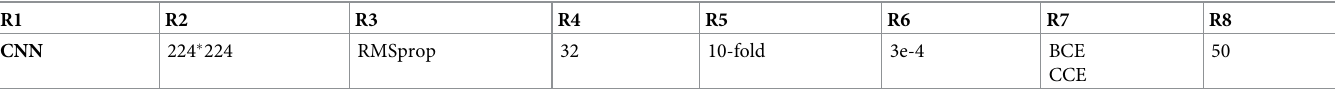
R1—Model, R2—Image Size, R3—Optimizers, R4—Mini Batch Size, R5—cross validation, R6—Initial Learning Rate, R7—Loss function, R8—Epoch, BCE—Binary cross-entropy, CCE—Categorical